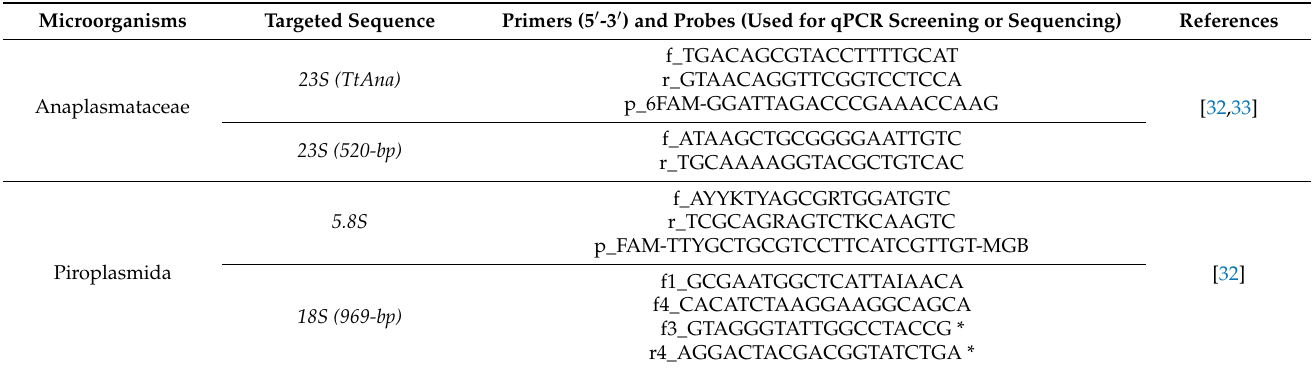
Table 1. Primers and probes used for quantitative real-time and standard PCR in this study. Microorganisms Targeted